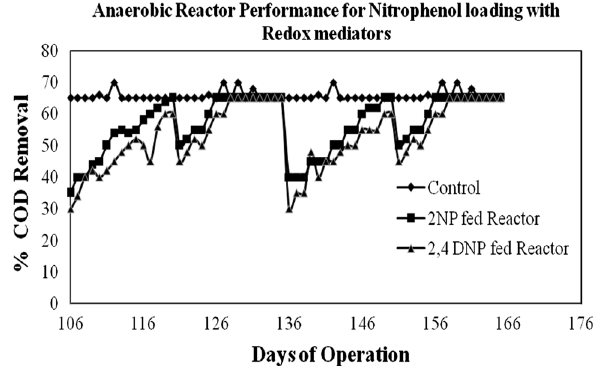
Fig. 5 COD removal for aerobic reactors during nitrophenol loading